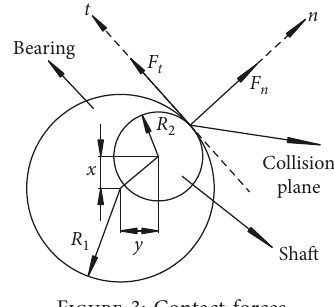
Figure 3: Contact forces.